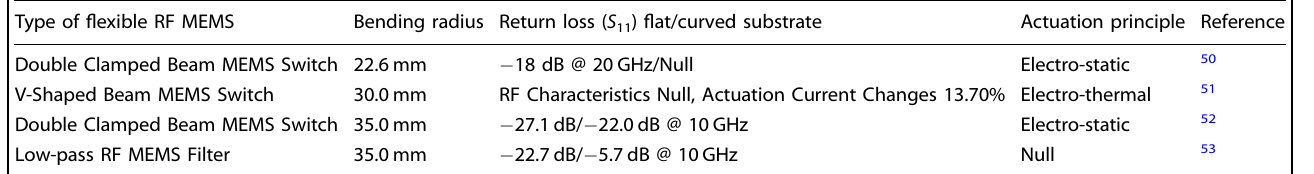
Table 1. Comparison of the performance of Flexible RF MEMS under bending